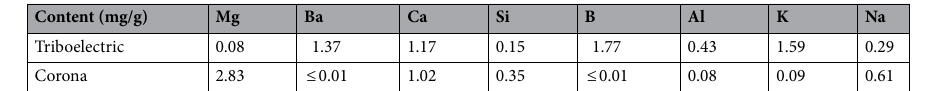
Table 2. metal and inorganic elements of triboelectric charging and corona charging masterbatches.